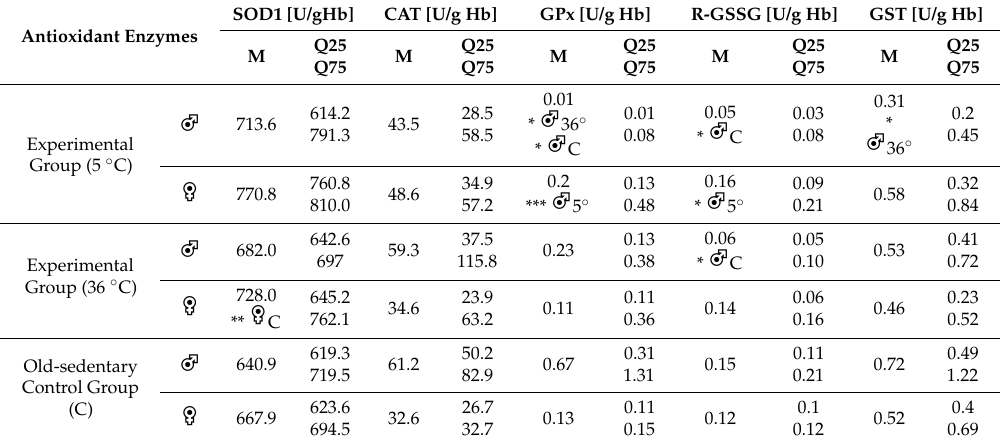
Table 2. Erythrocyte and plasma TBARS and 8-isoprostane concentrations in experimental groups (5 °C and 36 °C), control group and sex-specific differences.